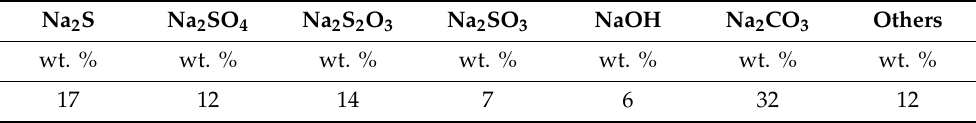
Table 3. Weight fractions of inorganic compounds in black liquor (dry matter basis). Other salts present in pine black liquor are mainly salts containing potassium and chlorine. Data is obtained from Niemelä and Al é n